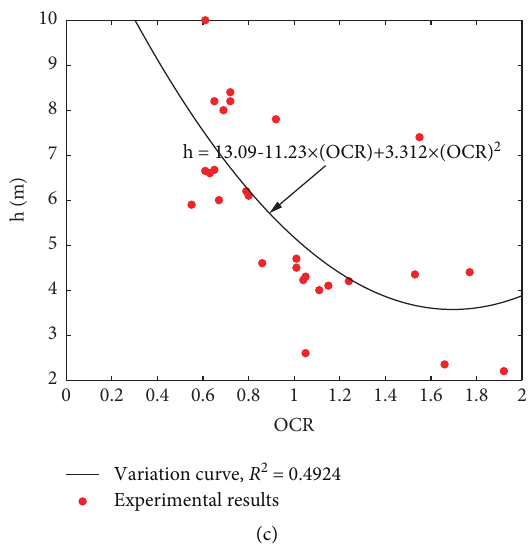
Figure 6: Variation curve of overconsolidation ratio with the depth in Shenzhen silt layer. (a) Project 1, (b) project 2, and (c) project 3.